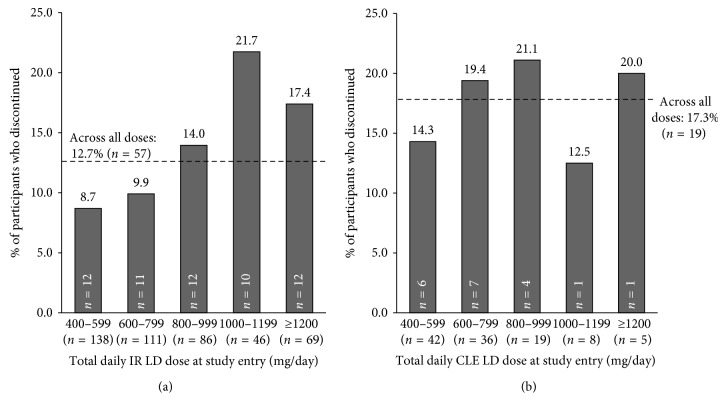
Proportions of participants who discontinued during dose conversion based on daily LD dose ranges at study entry during the conversion from IR CD-LD (a) or CLE (b). Proportions were calculated using the total number of participants who entered dose conversion (n=450 in (a) n=110 in (b)). The numbers of participants who discontinued from each dose range are indicated within each bar. The dashed lines represent the overall rate of discontinuation during dose conversion in each study.